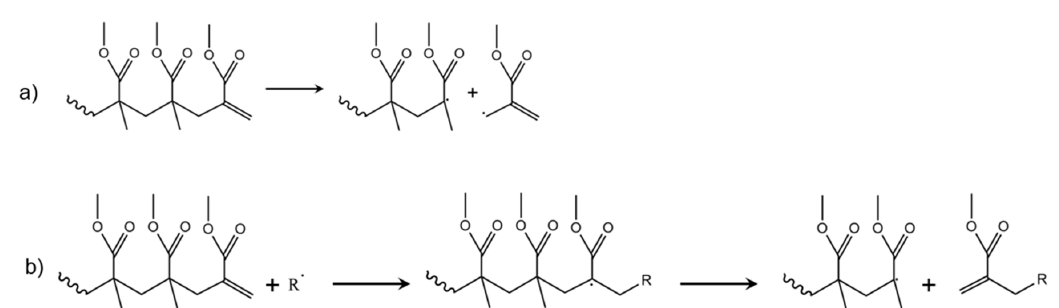
Figure 10. ( a ) Third thermal degradation initiation reaction based on chain-end fission thus involving the unsaturation as formed through termination by disproportionation during the synthesis; ( b ) Alternative based on addition of a general radical R, as introduced by Manring [30]. Here the initial and subsequent reaction ( β -scission) are depicted as their combination leads to a degradation initiation.